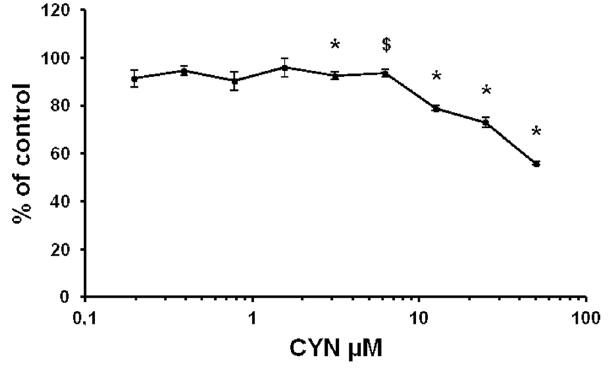
Figure 1. Cytotoxic effects of CYN in differentiated Caco-2 cells treated for 24 hrs. Cytotoxicity effect was measured by neutral red uptake assay. Values are presented as means 6 SE, and expressed as percentages of the vehicle control. Three independent experiments were performed. *, $ : values are (*, P , 0.05) or tended ( $ , P , 0.1) to be different from